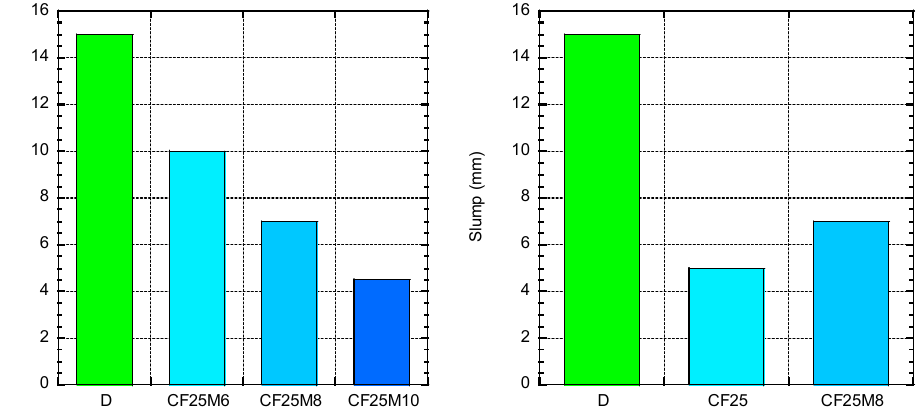
Figure 3. Slump of concrete containing different percentages of EAFS ( left ) and slump of concrete containing 25% of slag ( right ).